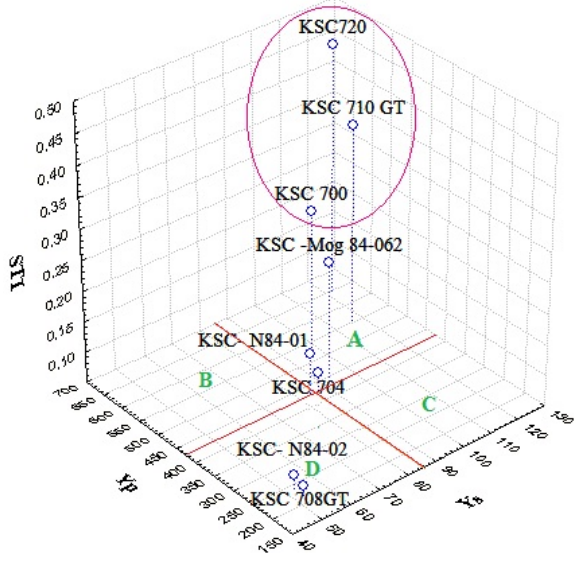
Fig. 1. The three dimensional plots among STI, Yp and Ys